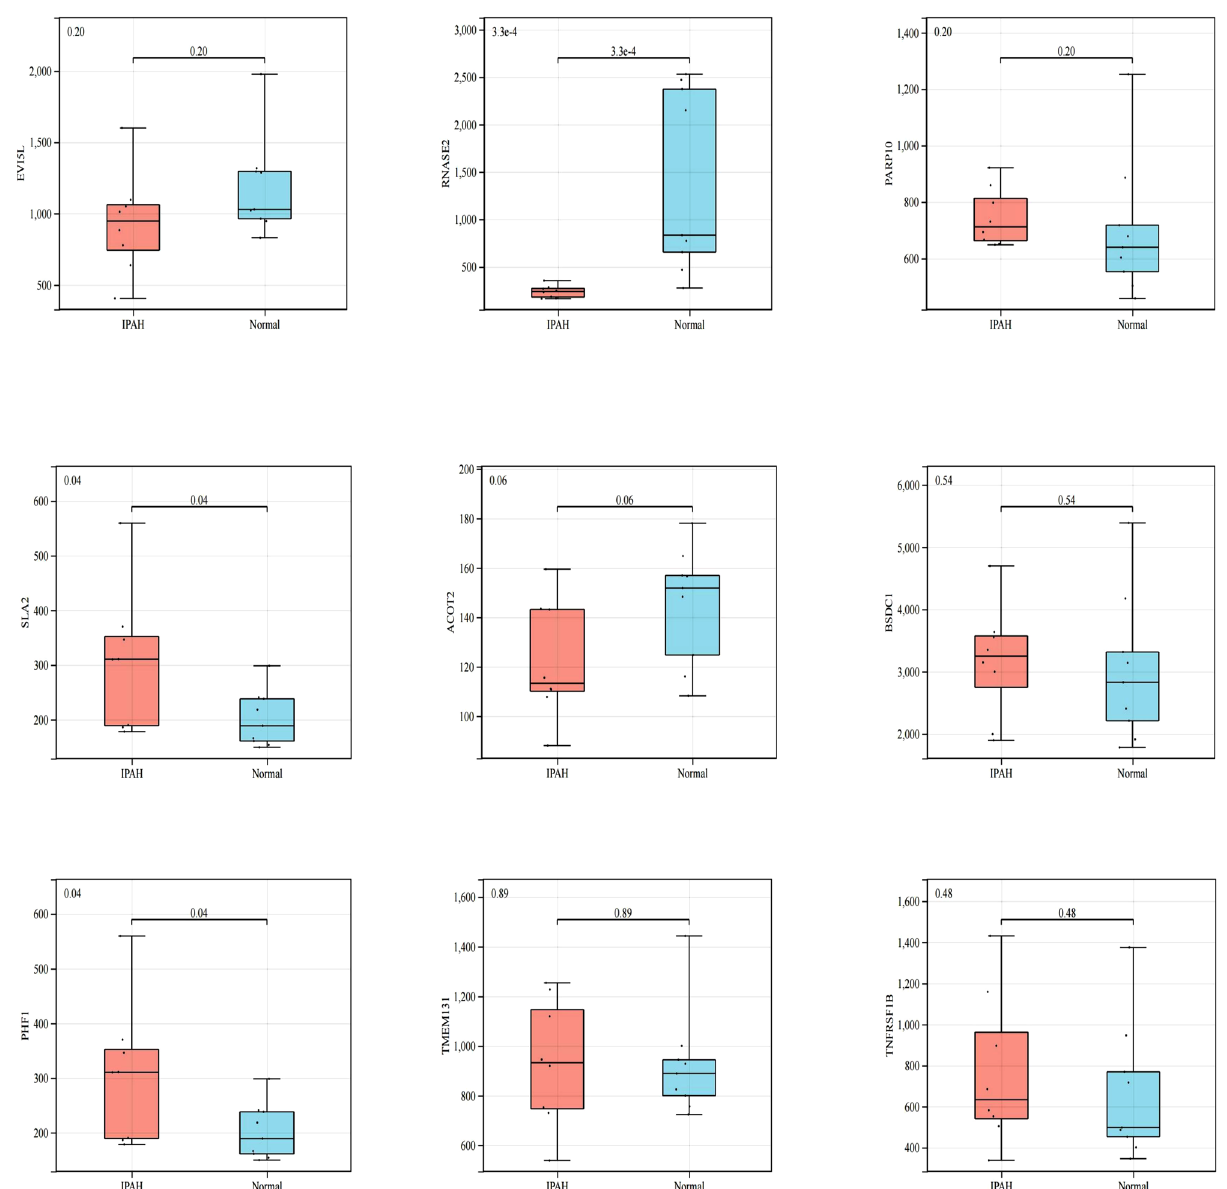
Figure 9. Lung tissue IPAH dataset GSE48149 verifies the expression of candidate diagnostic